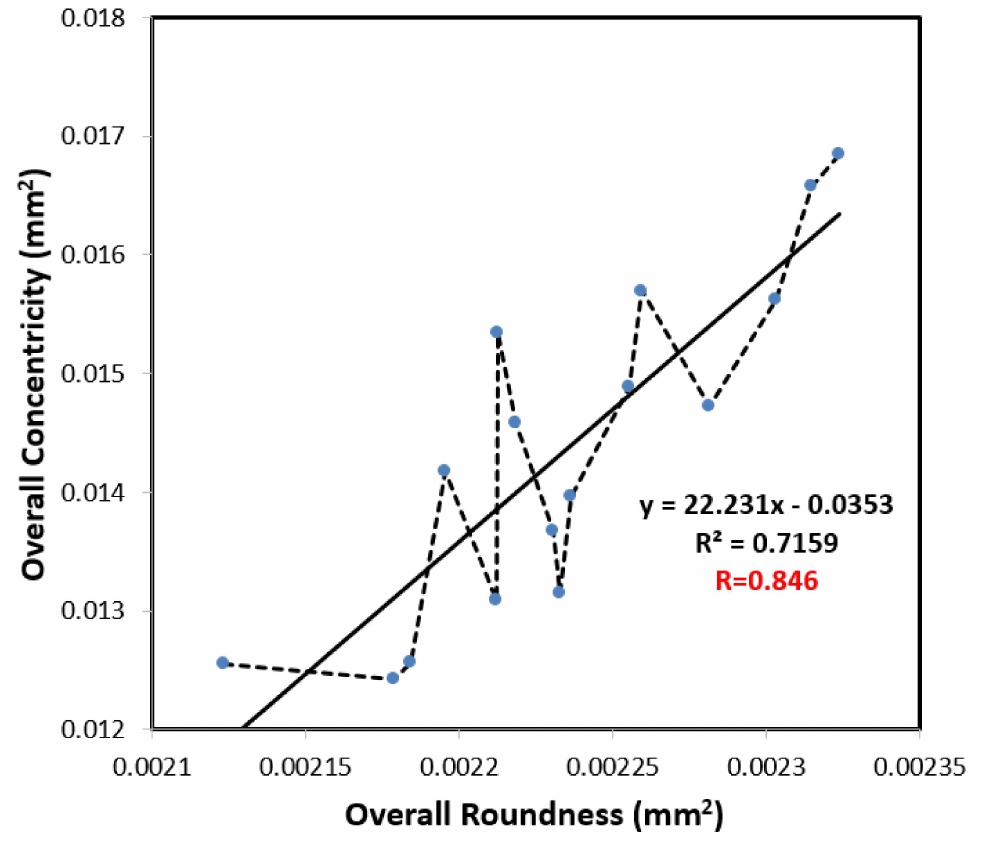
Figure 10. Analysis diagram of the correlation between overall roundness and overall